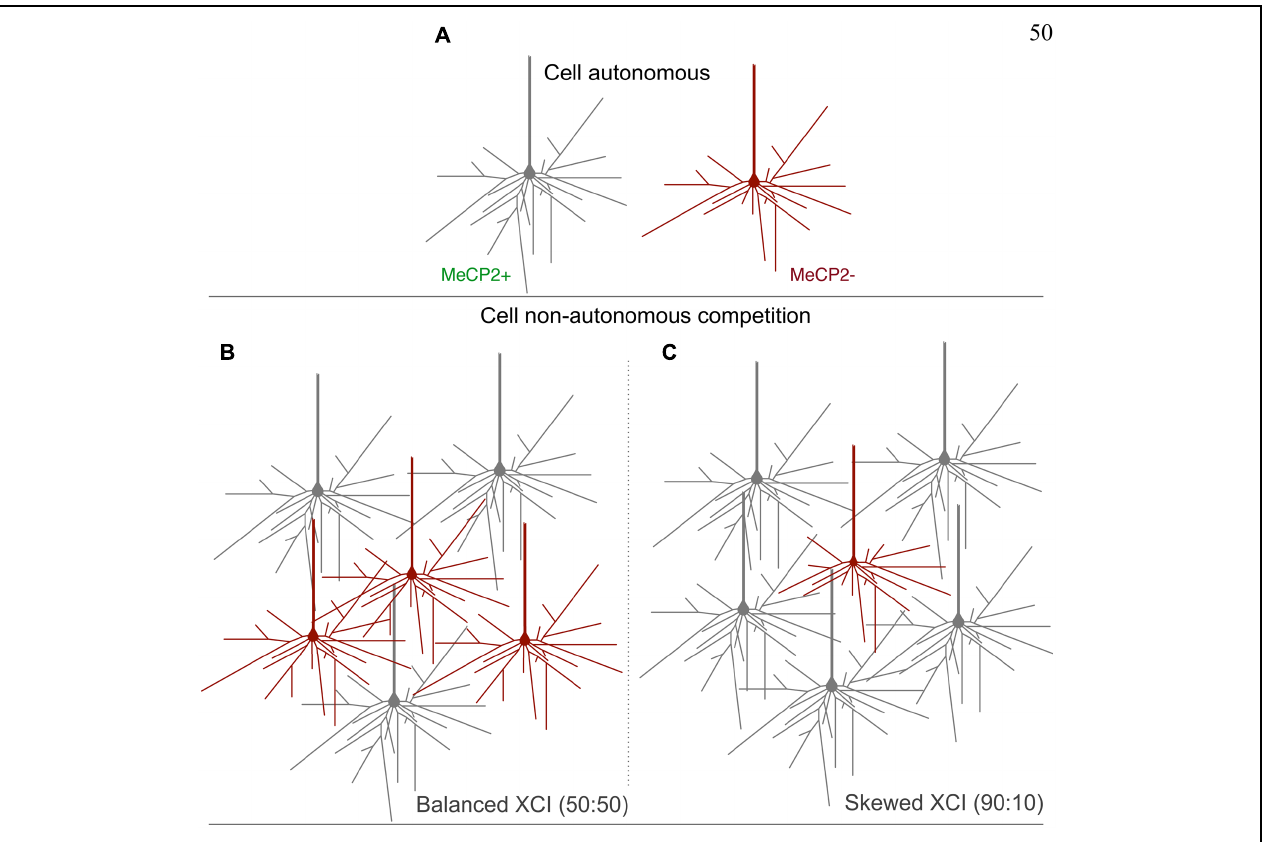
FIGURE 13 | Proposed model for cell non-autonomous effects of balanced and skewed XCI ratios. (A) Cell- autonomous effects on the morphology of MeCP2 − containing neurons, including reductions in dendritic length and fewer branch points compared to MeCP2 + cells, may render them less competitive for synaptic connections in the heterozygous brain. (B) A balanced XCI ratio may provide MeCP2 − neurons more